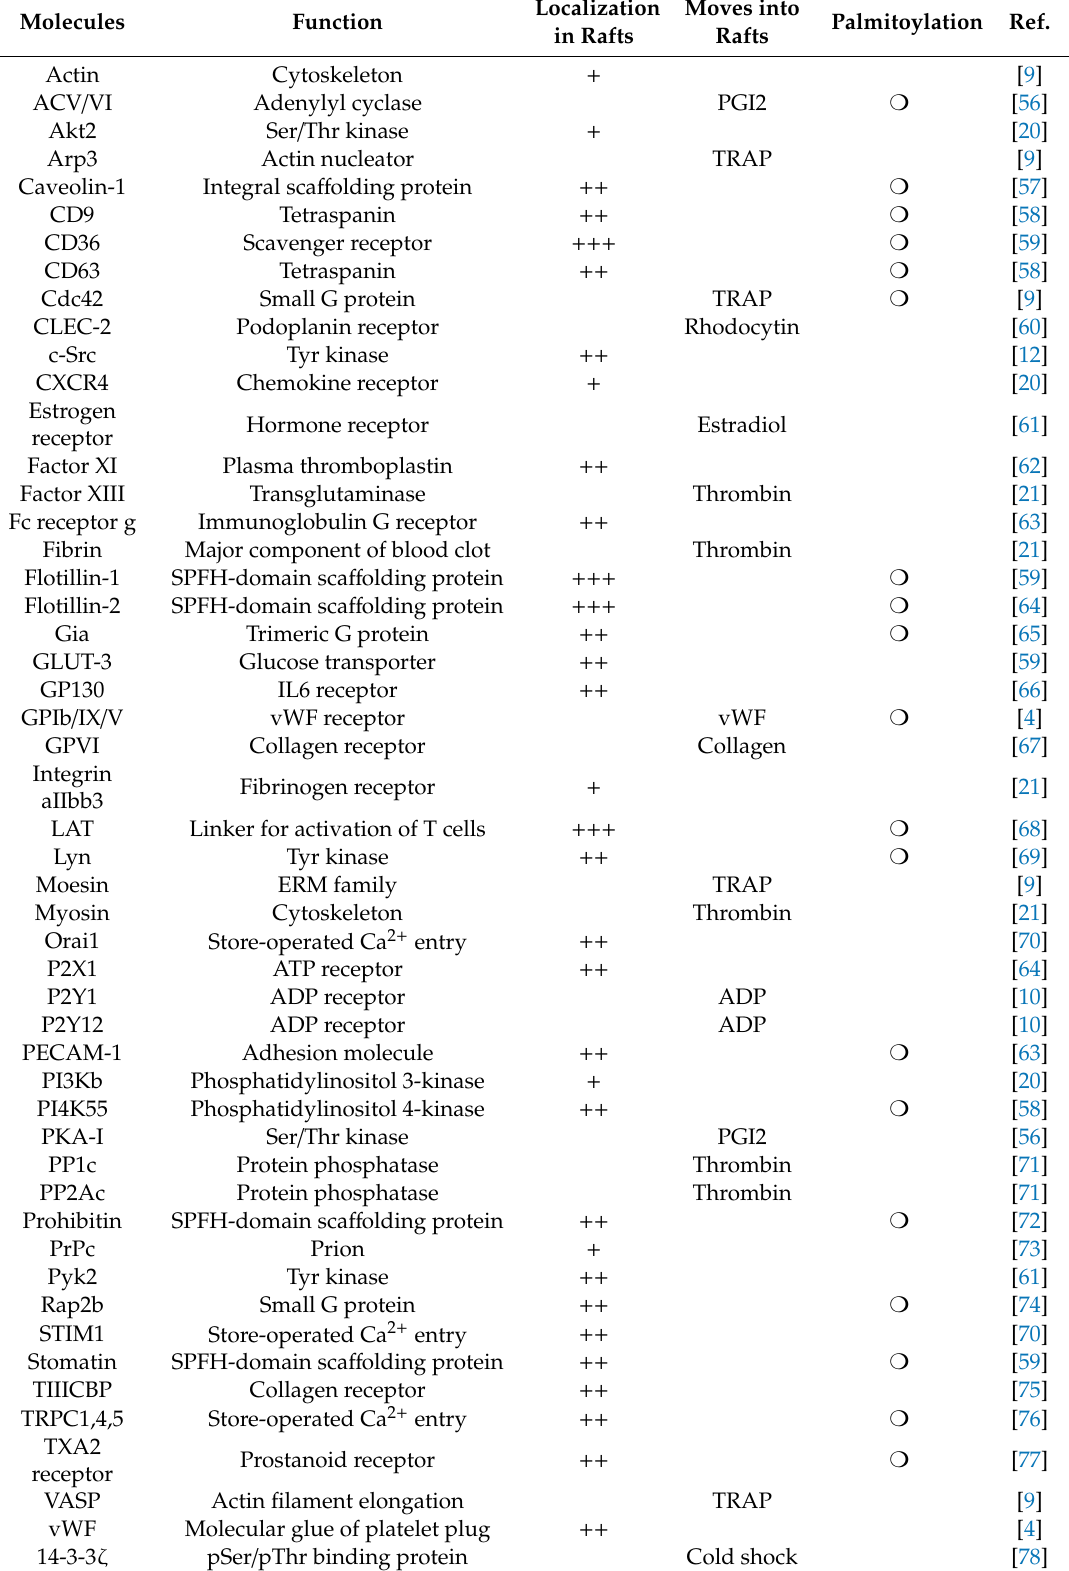
Table 1. Platelet raft-binding